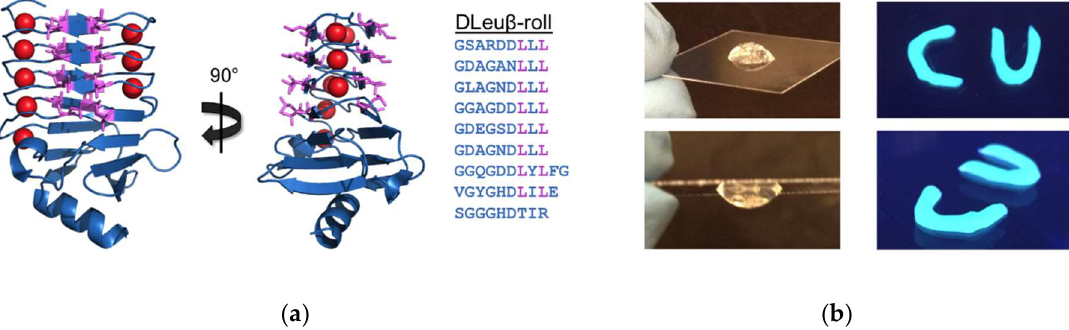
Figure 4. The DLeu β -roll as a stand-alone hydrogel building block. ( a ) The positions on both β -sheet faces were mutated to hydrophobic leucine residues. The folded conformation of the DLeu β -roll mutant is shown (PDB file: 5CVW) along with its peptide sequence with mutated positions in purple. ( b ) Exemplary pictures of hydrogel formed by MBP-DLeu β -roll-MBP-DLeu β -roll ( left ), and by the construct composed of DLeu β -roll and PN406 β -roll ( right ). The pictures on the right were taken under UV light to demonstrate the retention of the FITC-labeled target. Adapted with permission